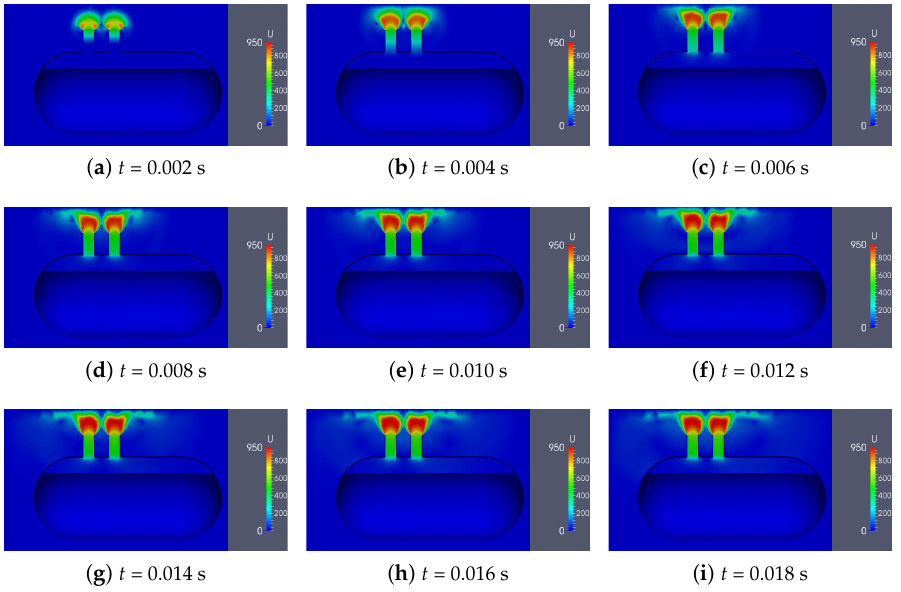
Figure 6. The velocity snapshots of a 3D transient simulation based on OpenFOAM ( ∆ t = 0.002 s).